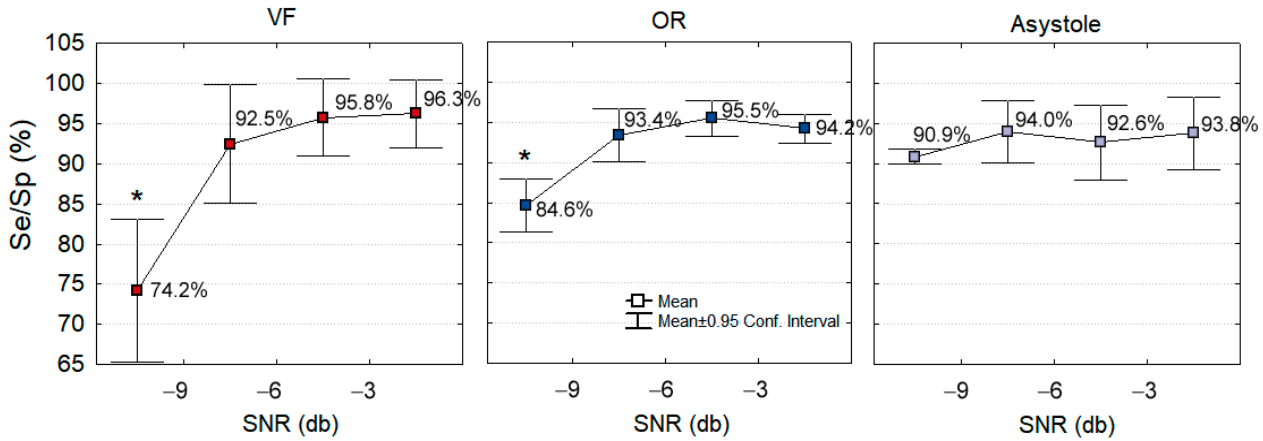
Figure 12. Dependency of CNN3-CC-ECG network performance on the CPR artifact corruption level in ECG estimated on the test database. The mean value and 95% confidence interval of Se (VF) and Sp (OR, Asystole) are presented in function of four SNR levels. Significant drop of performance is highlighted for Se (VF) and Sp (OR) at SNR < − 9 dB (* p < 0.05).